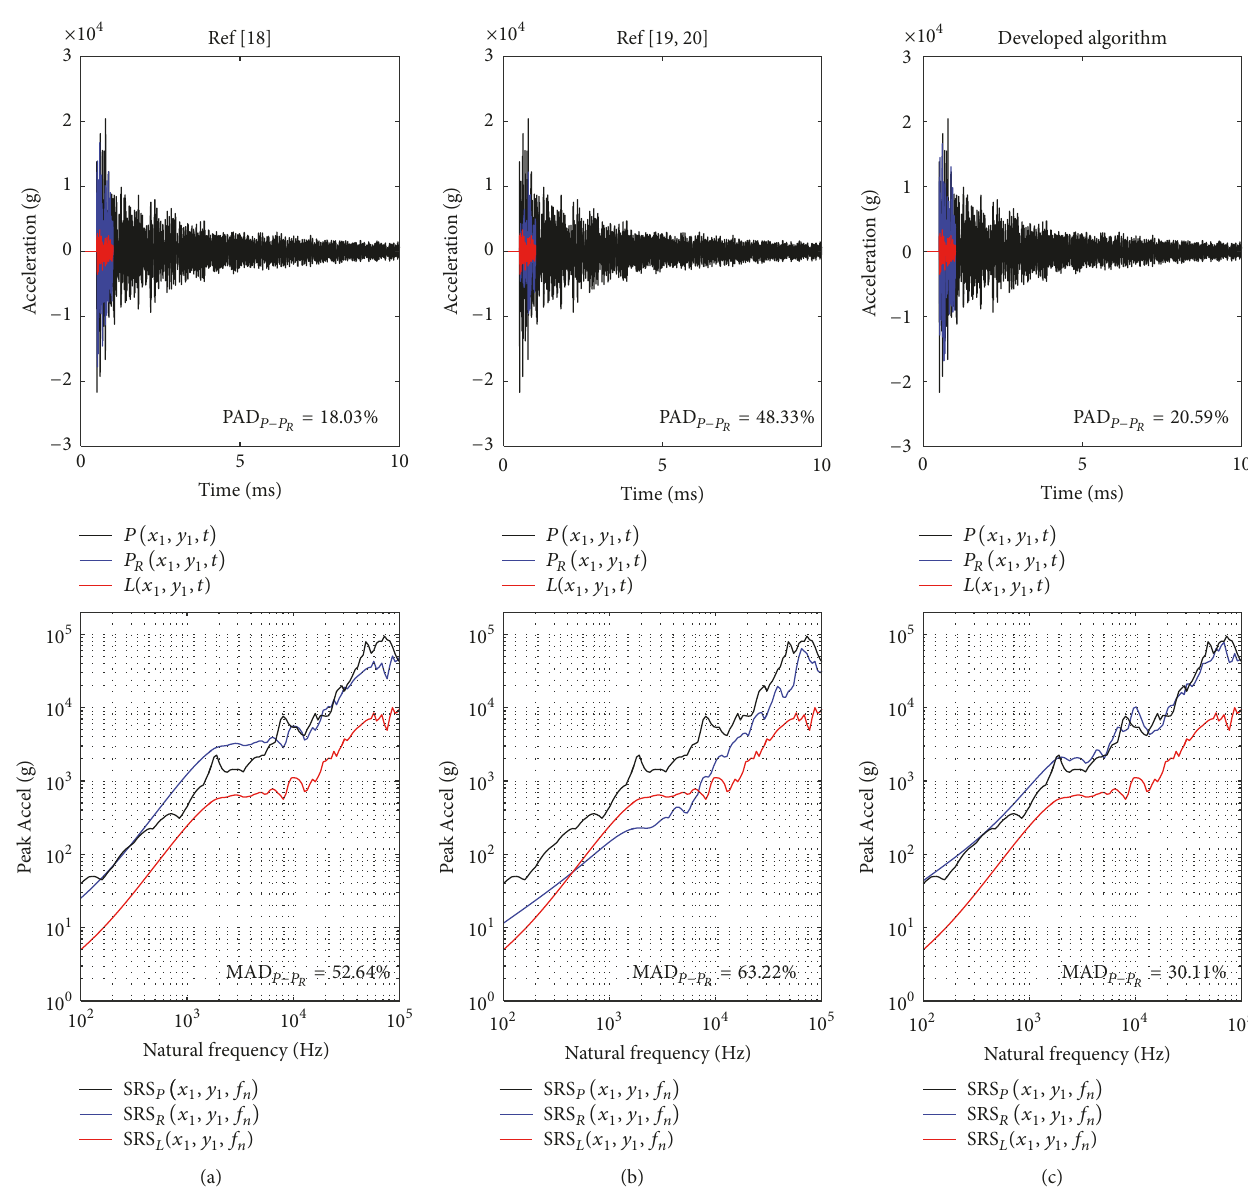
Figure 25: Reconstruction results of pyroshock on the disk type specimen at the verification point.